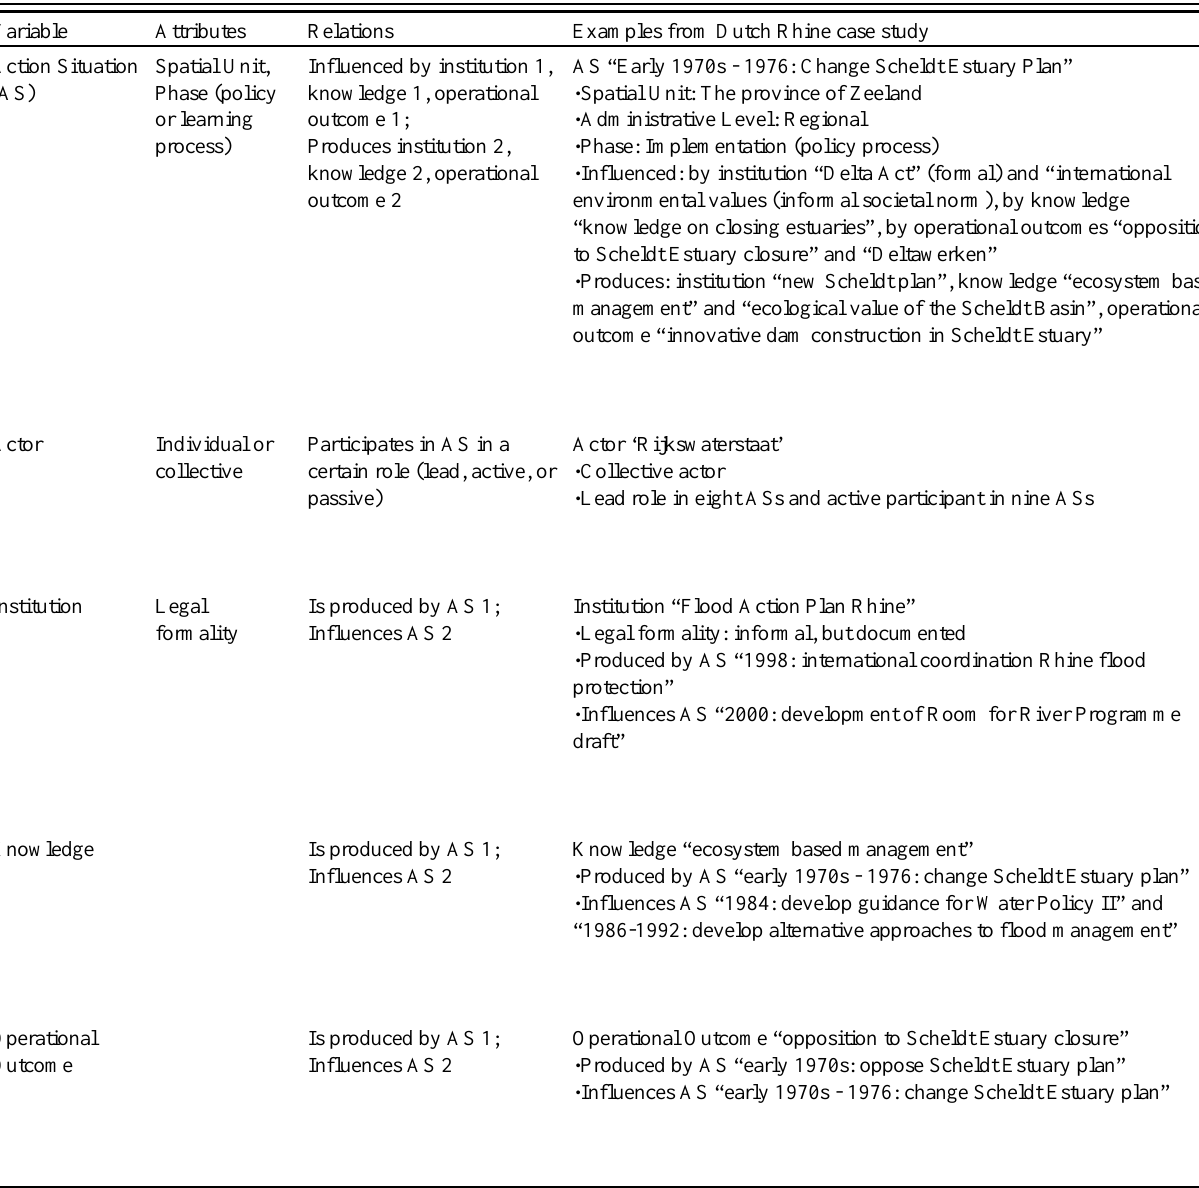
Table 2 . Data collected in the case